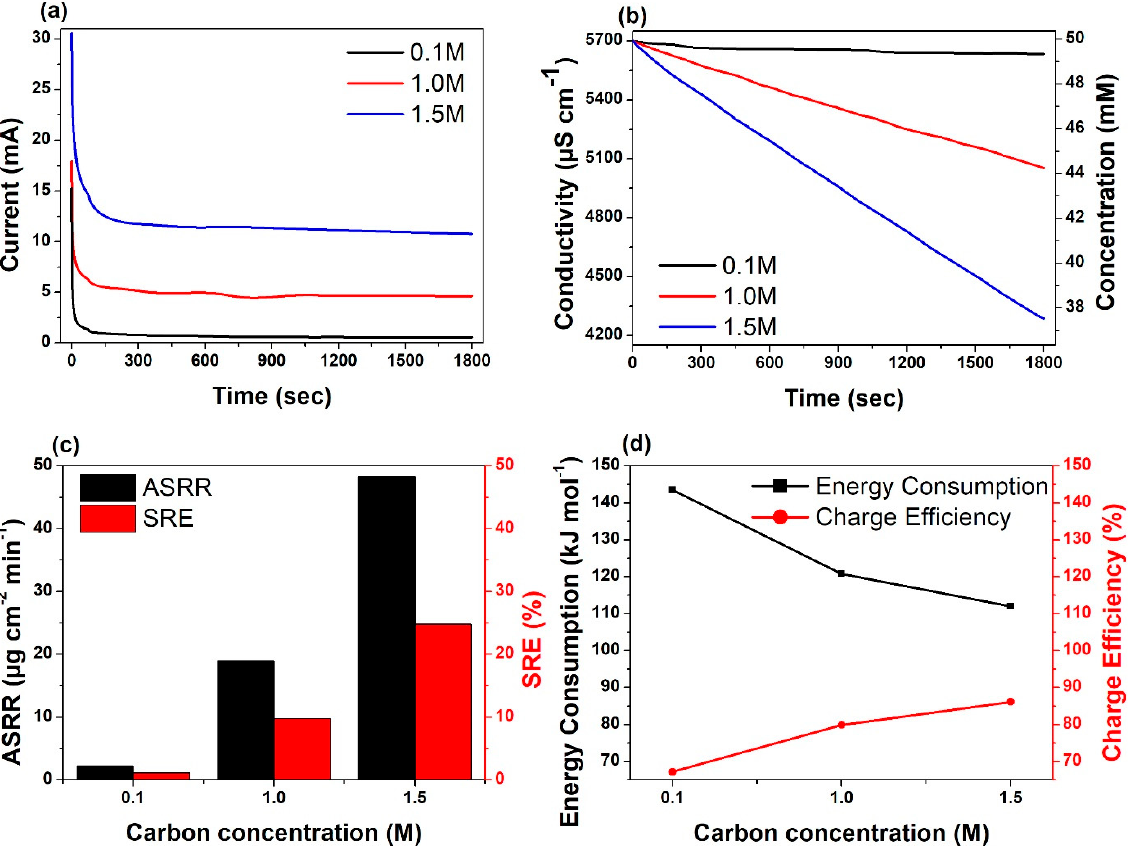
Figure 4. Effect of CB BP concentration in the flow electrode on the FCDI performance: ( a ) I-t curves with 1 V cell voltage, and the corresponding ( b ) conductivity and saline water concentration changes with time and ( c , d ) determined ASRR, SRE, EC and CE data.